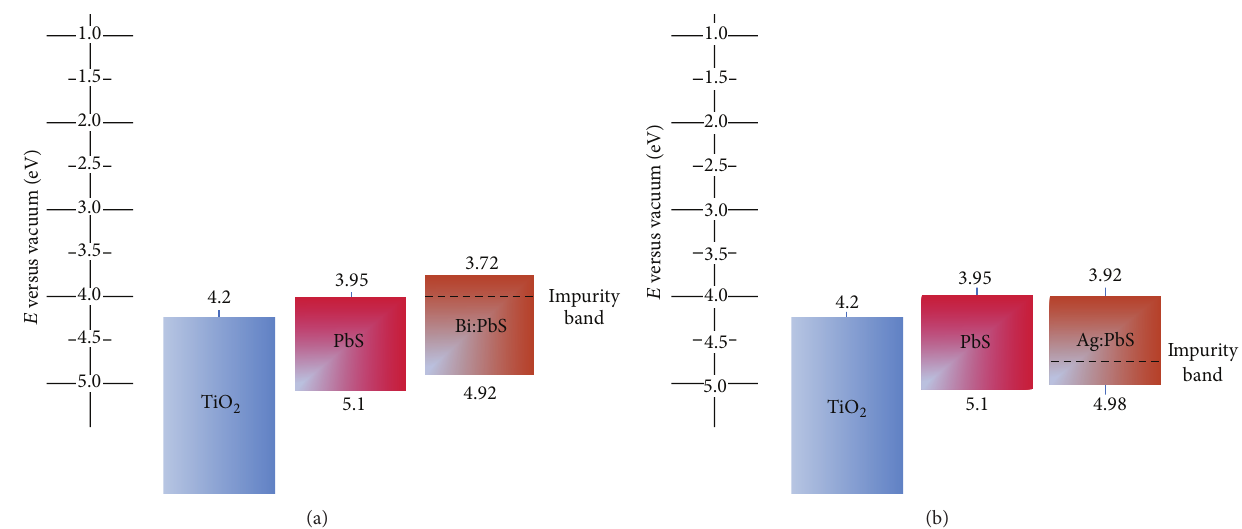
Figure 6: Band edge alignment diagram for (a) Bi-doped-PbS and (b) Ag-doped-PbS QDs.